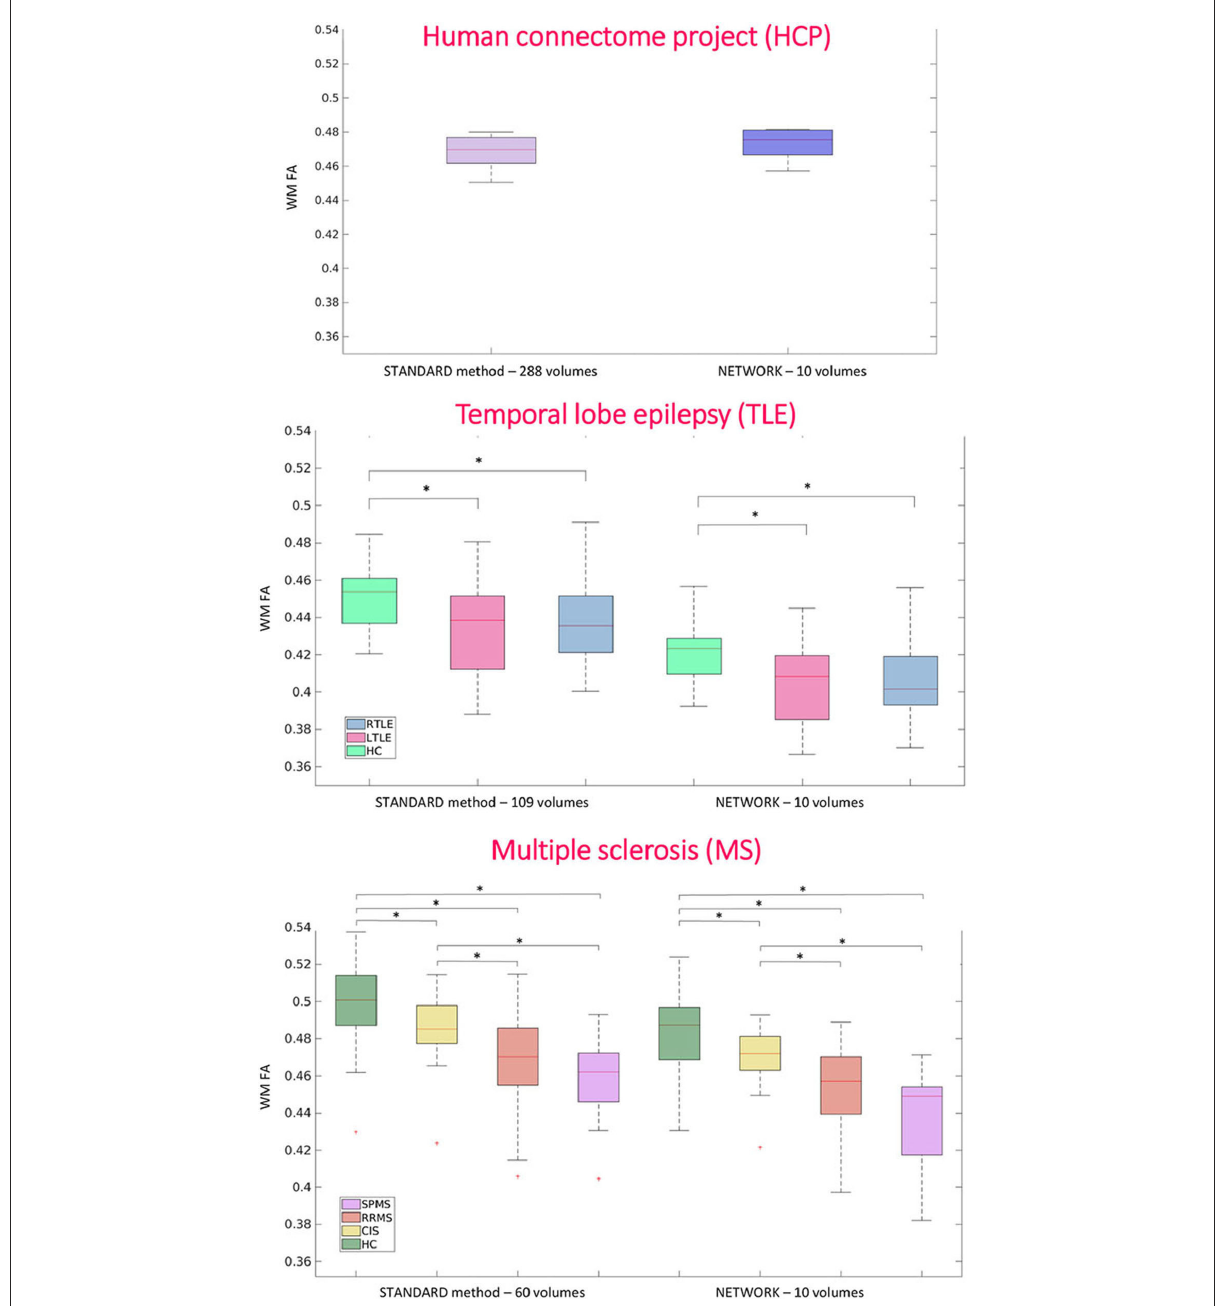
FIGURE8 Boxplots of white matter (WM) fractional anisotropy (FA) mean values for each dataset. In the first plot, the boxplots refer to the Human Connectome Project (HCP) test subjects. Plots show the average of WM FA calculated with the standard model-fitting method on the entire DW dataset as ground truth (STANDARD method − 288 volumes) and of WM FA values obtained with the network and a subset of 10 DW volumes as input (NETWORK − 10 volumes). In the second plot, the boxplots refer to the temporal lobe epilepsy (TLE) subjects divided by groups: Healthy Control (HC), Left TLE (LTLE), and Right TLE (RTLE), considering the mean value of white matter fractional anisotropy of the ground truth (STANDARD method − 109 volumes) and of the network (NETWORK − 10 volumes). Significant differences are indicated with an asterisk ( p < 0.05). The boxplots of the WM FA (or NAWM) refer to multiple sclerosis (MS) subjects divided by group healthy control (HC), clinical isolated syndrome (CIS), relapsing—remitting MS (RRMS), and secondary progressive MS (SPMS) considering the mean value white matter fractional anisotropy of the ground truth (STANDARD method − 60 volumes) and of the network (NETWORK − 10 volumes). Significant differences are indicated with an